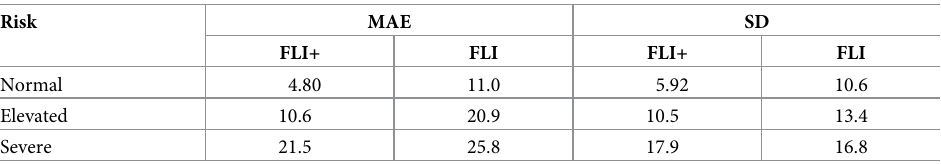
Table 4. Mean performance of FLI+ and FLI stratified by risk